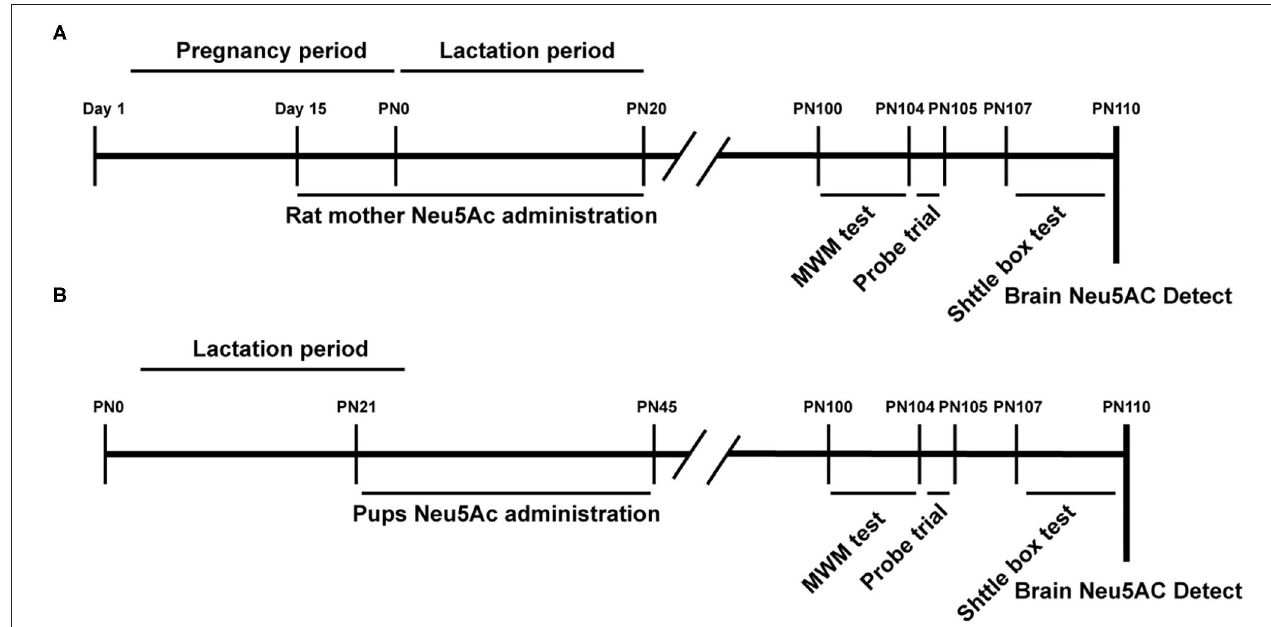
FIGURE 1 | Experimental design scheme. PN, Postnatal day; Neu5Ac, N-acetylneuraminic acid; MWM, Morris Water Maze; shuttle box test. (A) Maternal Neu 5Ac supplementation group; (B) Rat pups Neu5Ac supplementation